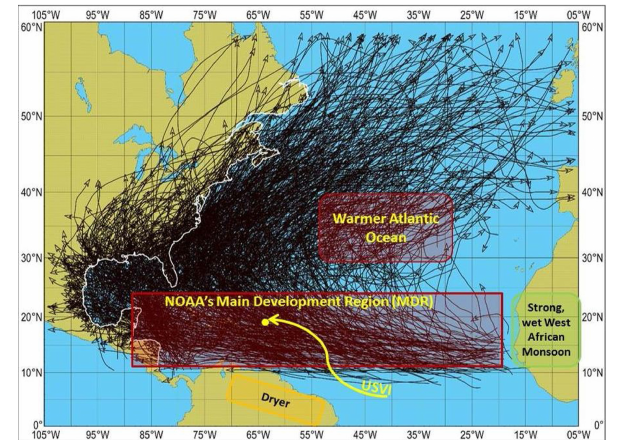
Fig. 1. MDR and hurricane tracks 1851–2004. The arrow indicates the location of the USVI within the sector designated as the Main Development Region (MDR) for tropical storm activity since 1995 in the months August through October (synthesis of NOAA graph- ics, after Climate Prediction Center,